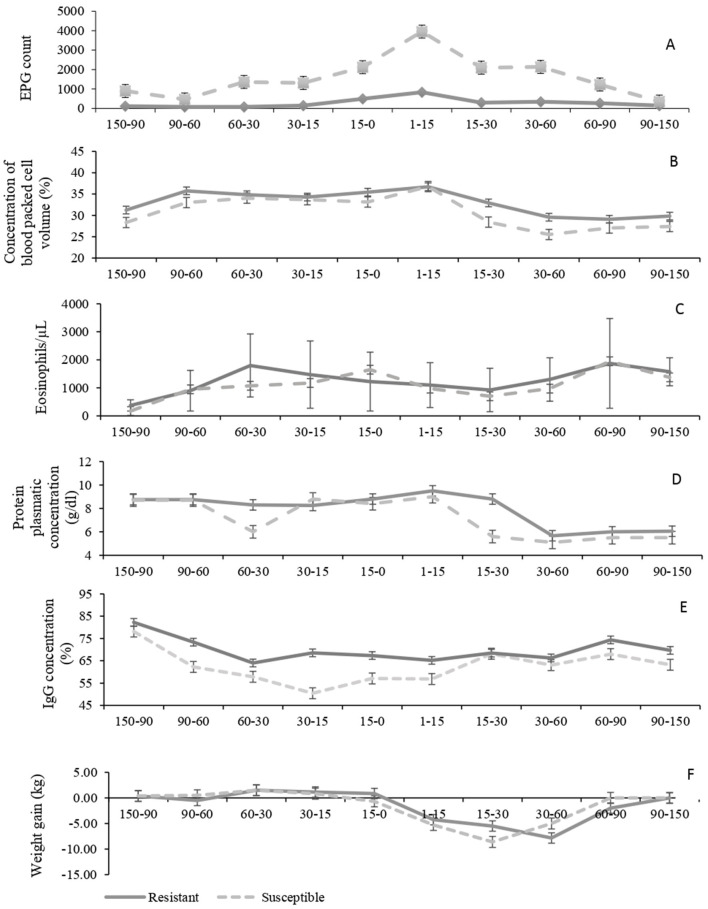
Mean values of egg counts per gram of feces (EPG) (A), packed cell volmne (PCV) (B), blood eosinophil counts (C), total plasma protein (TPP) (D), concentrations of IgG (E) and weekly weight variation (F) in Crioula Lanada ewes, susceptible (N = 6) and resistant (N = 12) to gastrointestinal nematodes during the gestation and lactation phases in the 2 years evaluated: 150–0 days before parturition and 1–150 days postpartum. Error bars indicate standard error of mean.